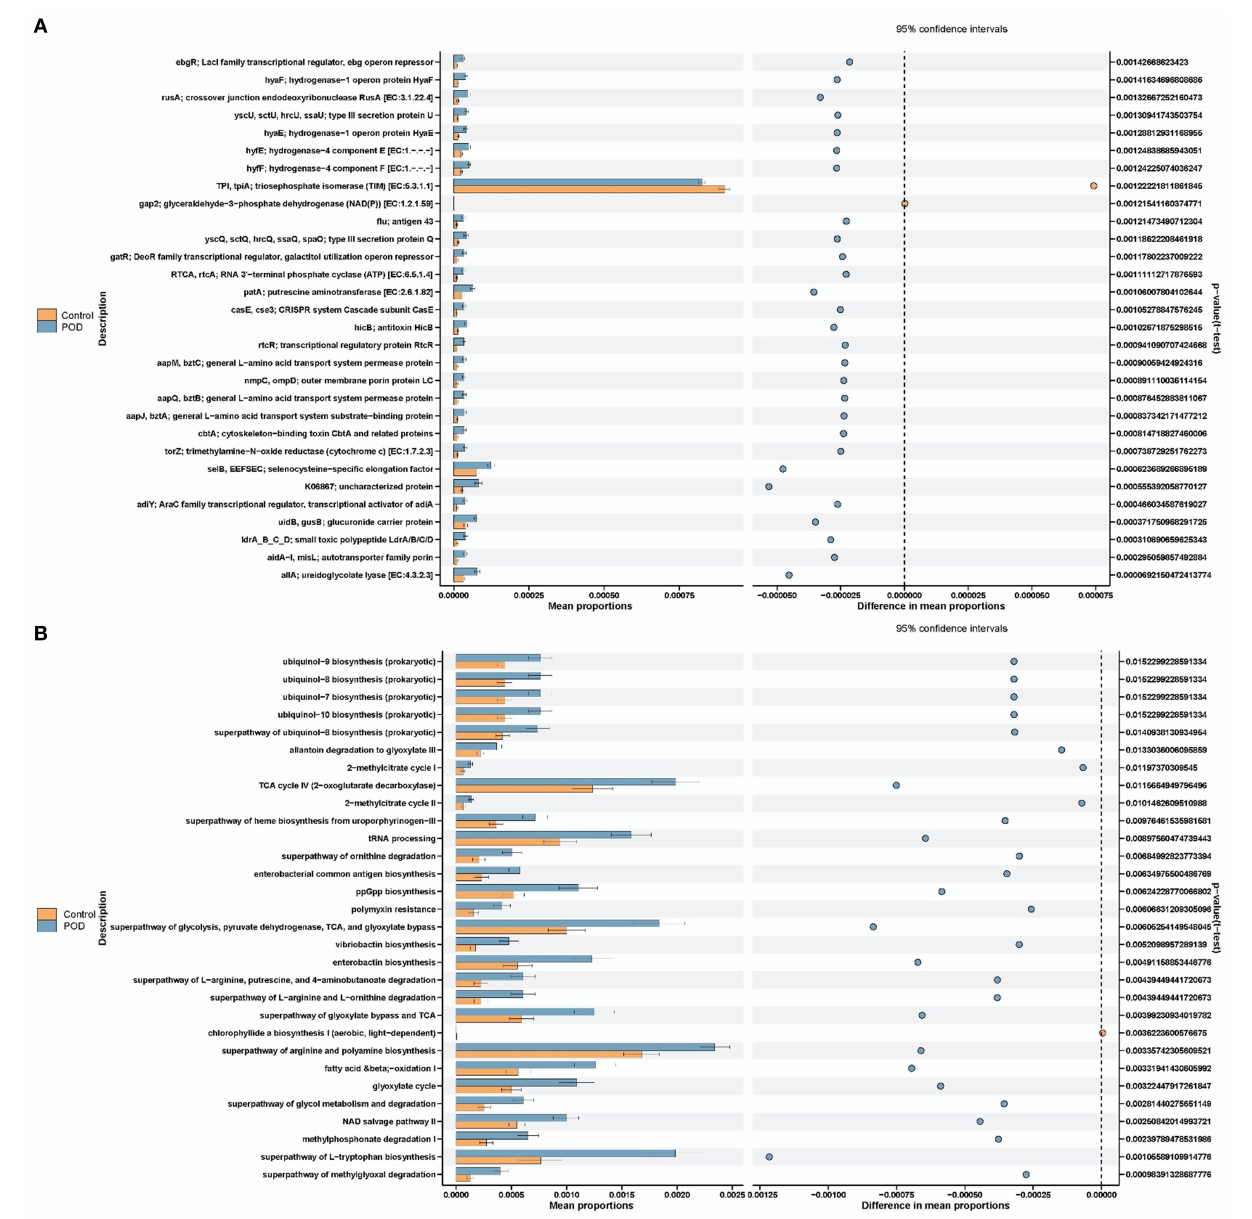
FIGURE 4 | Functional prediction by phylogenetic investigation of communities by reconstruction of unobserved states. (A) KO prediction. (B) Pathway abundance